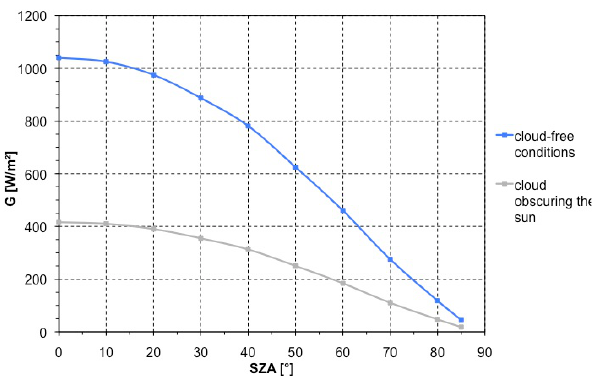
Fig. 8. Global solar irradiance as function of solar zenith angle for average cloud-free conditions and for conditions with a cloud obscuring the